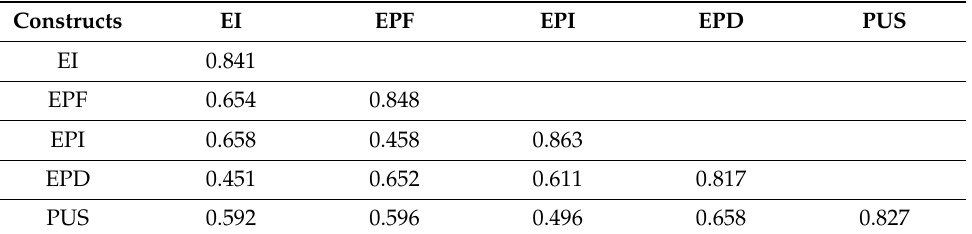
Table 2. Discriminant validity (Fornell and Larcker criteria).